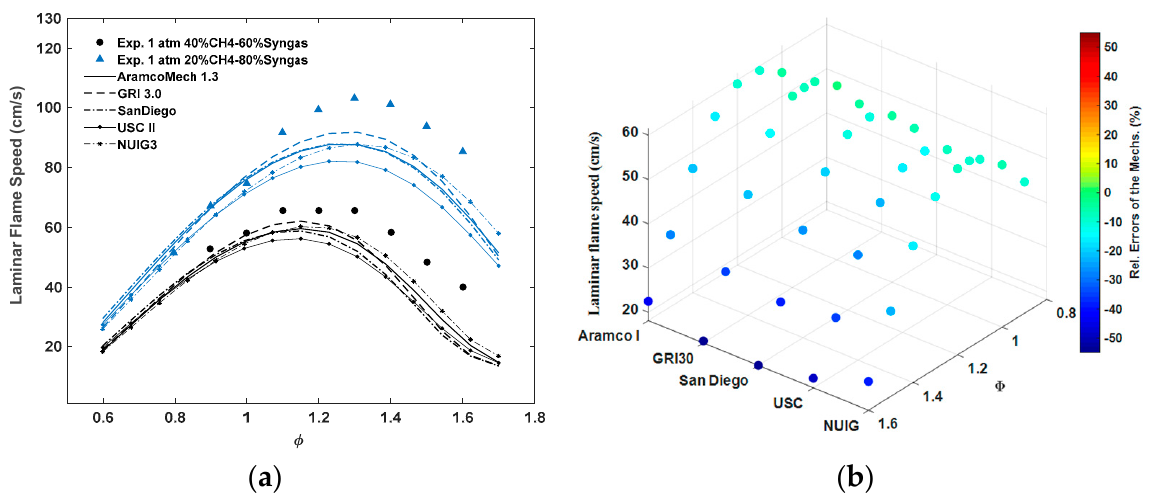
Figure 7. ( a ) Comparison of laminar flame speed with the experimental data of CH 4 /H 2 /CO mixtures [43]; ( b ) The relative error of simulation from experiments.